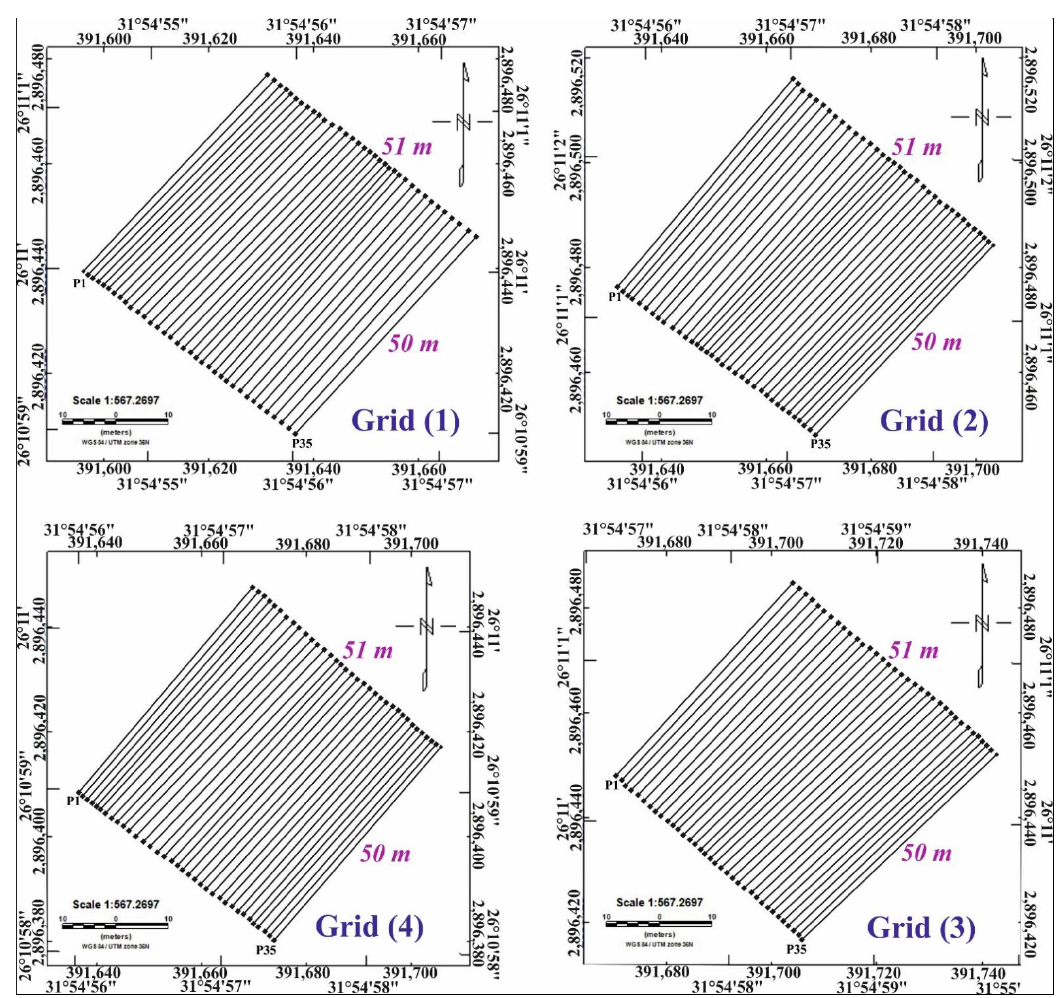
Figure 5. Locations of the GPR profiles in the study region, where the main site was categorized into four grids for implementation of the radar field survey. Every grid was surveyed with 35 parallel profiles with a length of 50 m conducing 140 profiles for the total work.